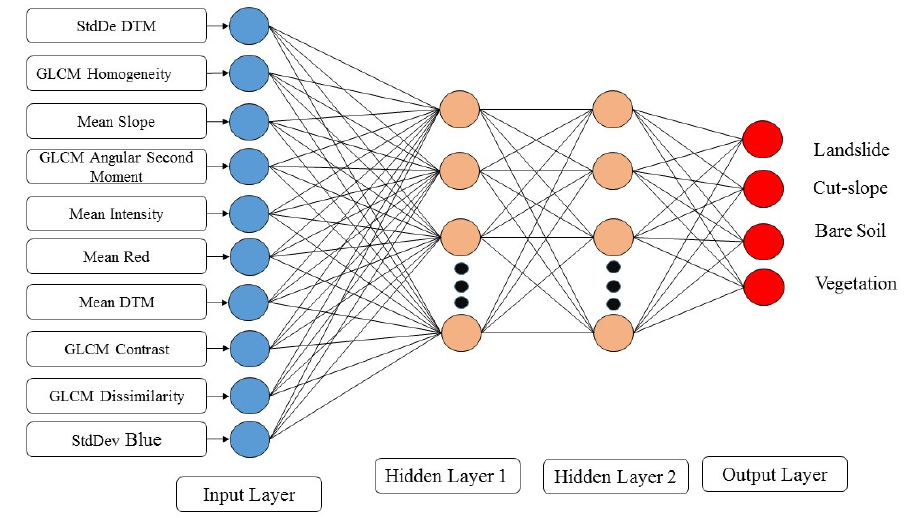
Figure 6. Architecture of the MLR-NN model; GLCM: gray level co-occurrence matrix, StdDev: standard deviation.